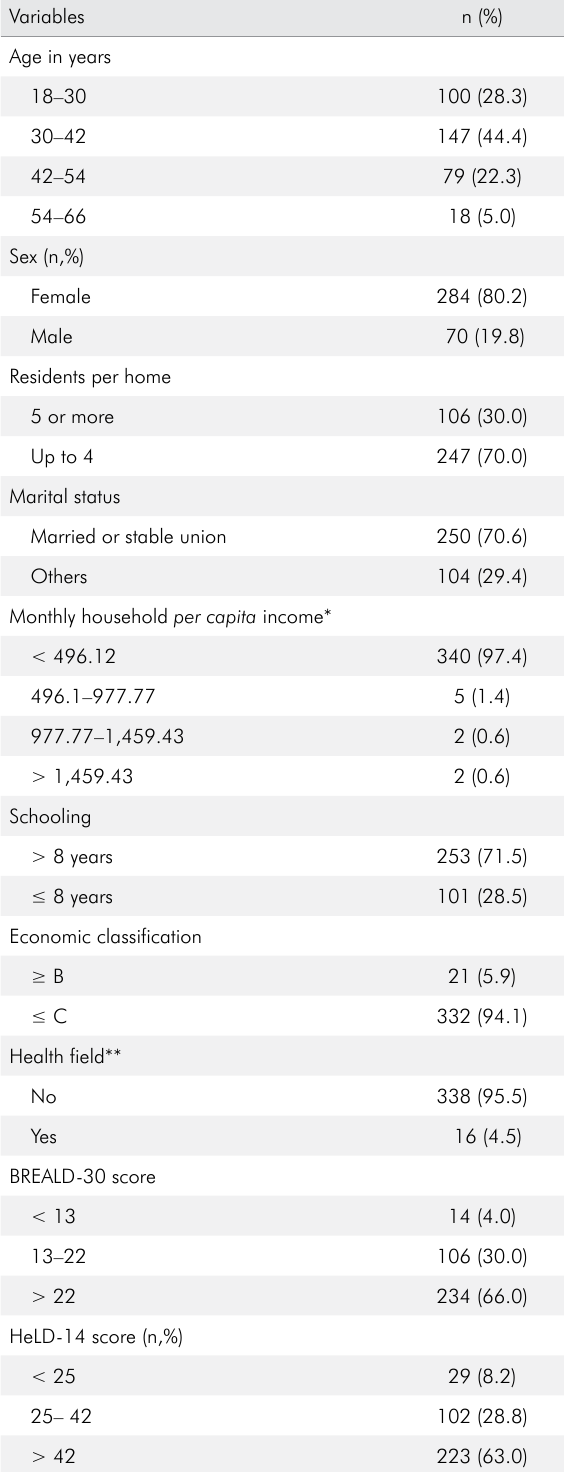
Table 1. Characteristics of the study population (n = 354) (Curitiba, Brazil,